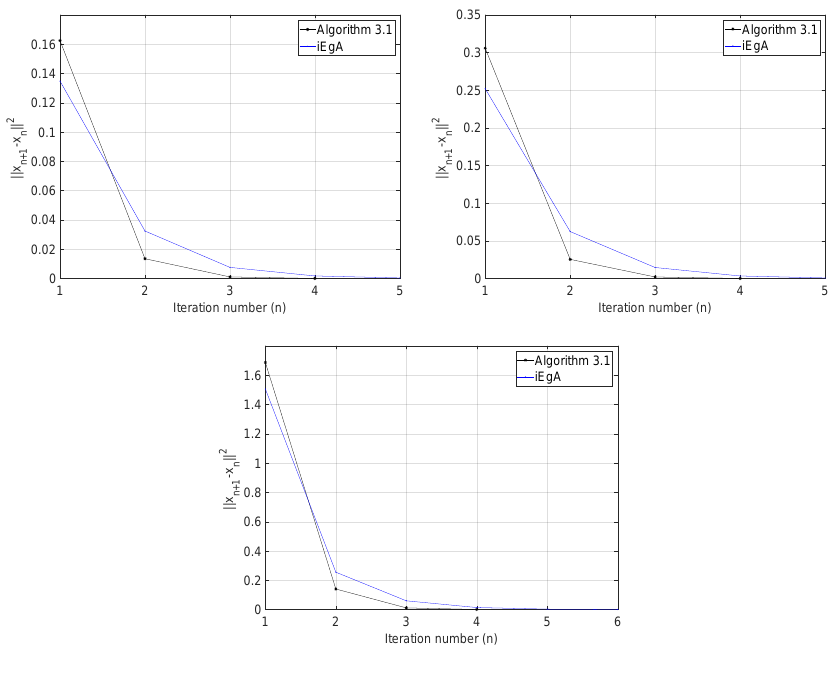
Figure 2: Example 4.2, Top-Left: Case(i); Top-Right: Case(ii); Bottom: Case(iii).